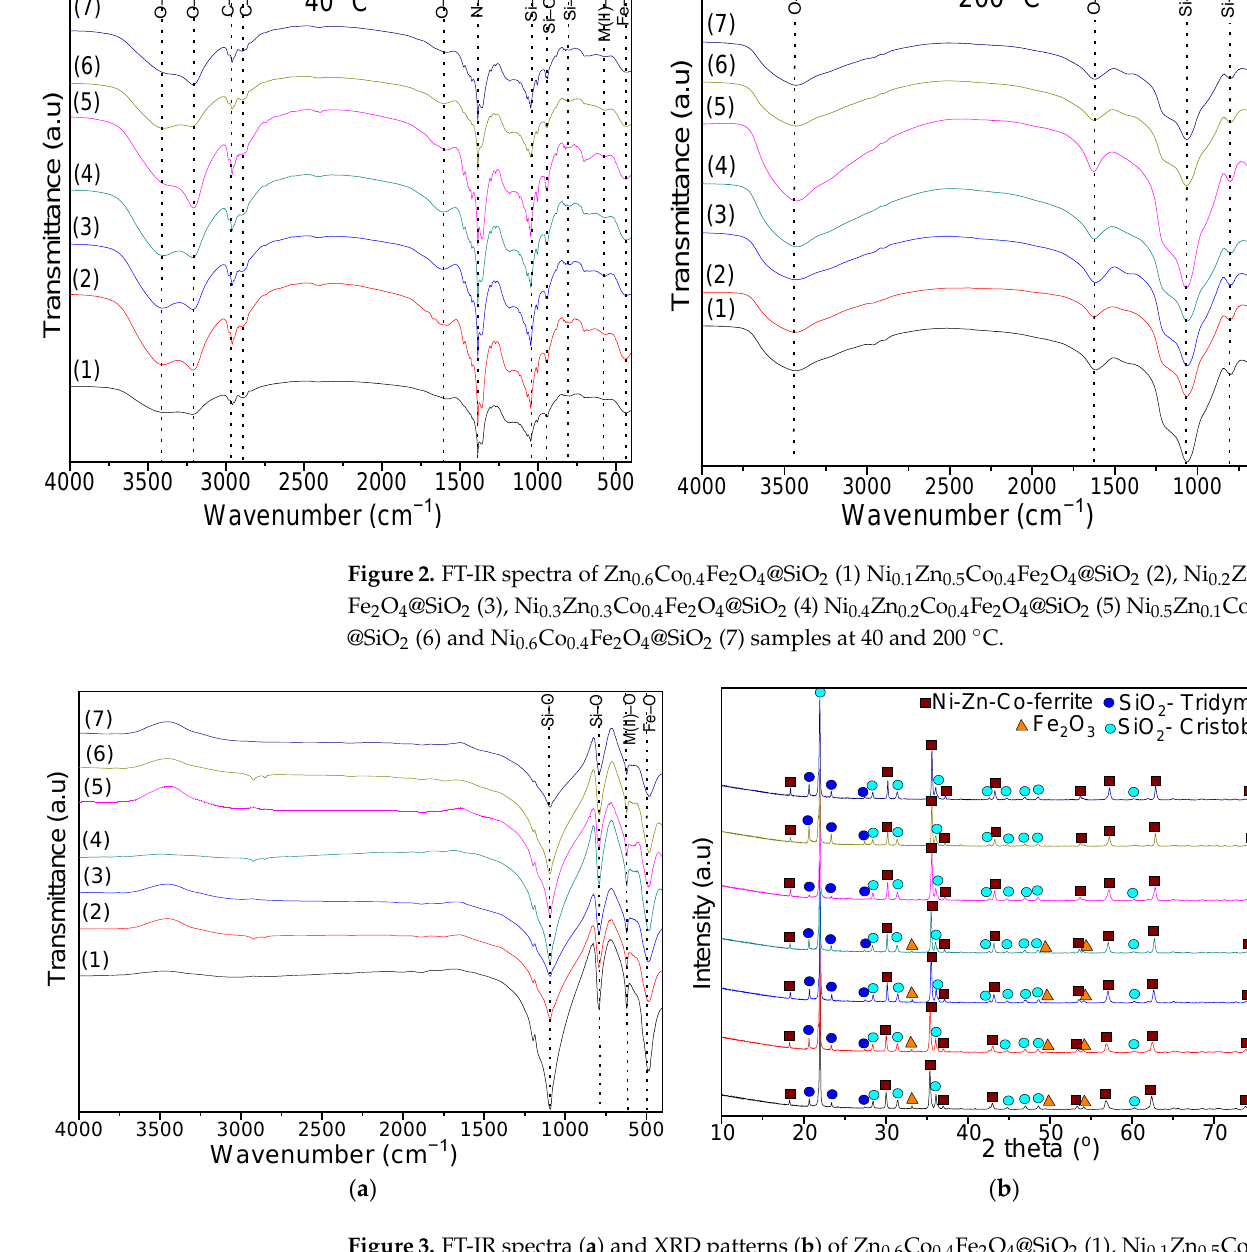
Ni 0.3 Zn 0.3 Co 0.4 Fe 2 O 4 @SiO 2 ,